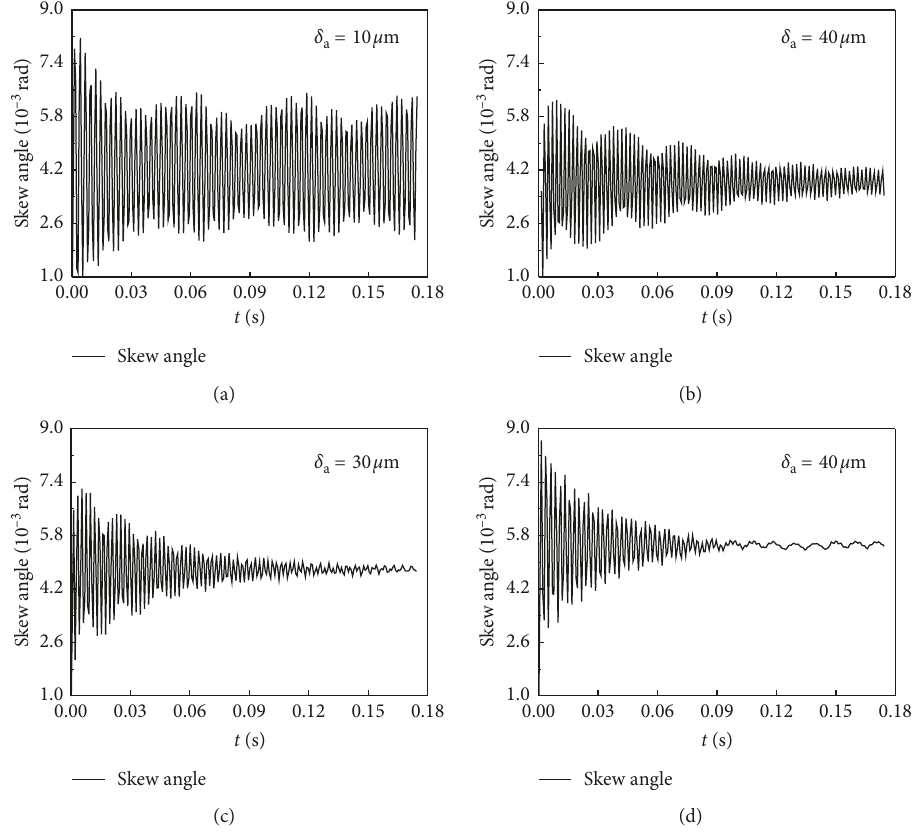
Figure 11: The skew angle of the conical roller. F